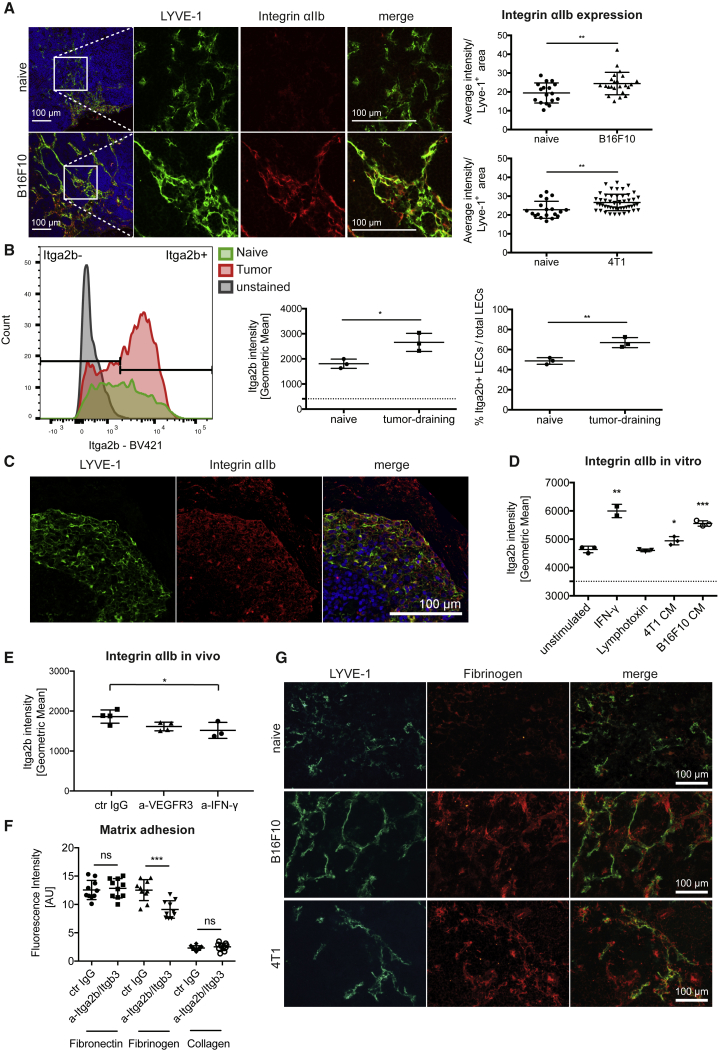
Integrin αIIb Is Upregulated on LECs in Tumor-Draining LNs and Mediates Adhesion of LN LECs to Fibrinogen In Vitro(A) Representative images and quantification of integrin αIIb immunofluorescence stainings. Each dot represents one image; n = 8 LNs/group.(B) FACS analysis of integrin-αIIb-positive LECs in 4T1 tumor-draining LNs. n = 3 LNs/group.(C) Representative images of integrin αIIb expression in the subcapsular sinus of a human melanoma-draining LN.(D) FACS analysis of integrin αIIb expression on primary murine LN LECs in vitro after stimulation for 24 hr. Points represent biological replicates (n = 2–3).(E) FACS analysis of integrin αIIb expression by LN LECs in vivo in 4T1-bearing mice on day 10 after tumor implantation in response to VEGFR-3 and IFN-γ blockage. n = 3–4 mice/group.(F) Matrix adhesion assay of primary murine LN LECs under integrin αIIbβ3 blockage in vitro. Points represent biological replicates (n = 10).(G) LYVE-1/fibrinogen immunofluorescence stainings of naive and tumor-draining LNs.Statistical significance was determined by the unpaired Student’s t test (A, B, D [each group compared to the unstimulated control] and F) and one-way ANOVA (E). Data are shown as mean with SD and differences were considered statistically significant when p < 0.05, as indicated by ∗p < 0.05, ∗∗p < 0.01, and ∗∗∗p < 0.001. See also Figure S4.